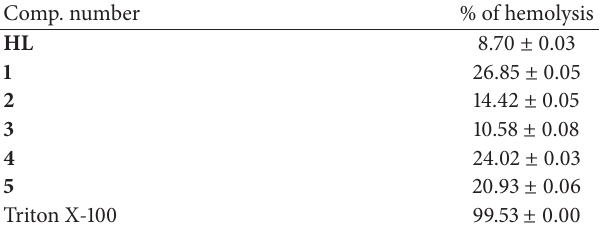
Table 14: Hemolytic activity of organotin complexes 1–5 . Comp.